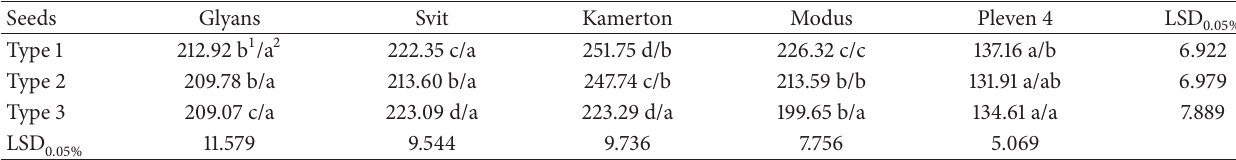
Table 2: Weight of 1000 seeds (g) of seed types in pea cultivars.